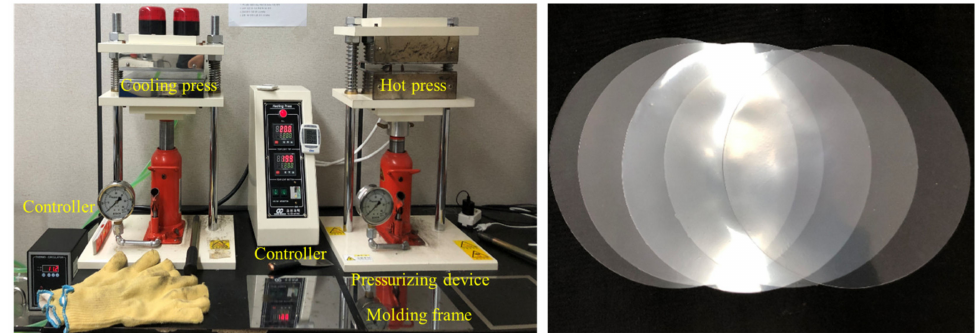
Figure 2. The equipment for manufacturing test